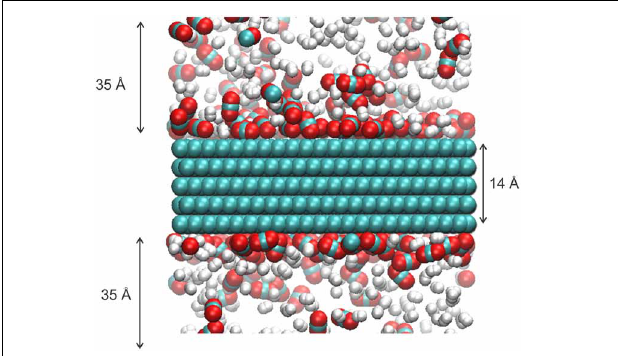
FIGURE 1 | Typical snapshot of the gas mixture of CO 2 and H 2 in equilibrium with a graphite surface. The temperature is T = 300K and the number of particles is N = 700. The green, red, white are represented carbon, oxygen, and hydrogen atom,